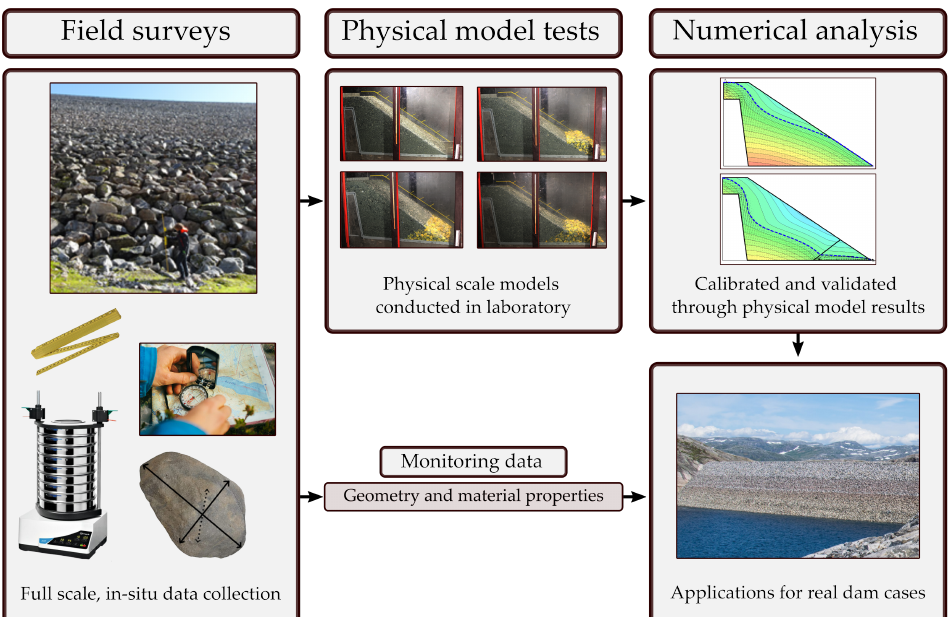
Figure 3. Schematic overview of the overarching research